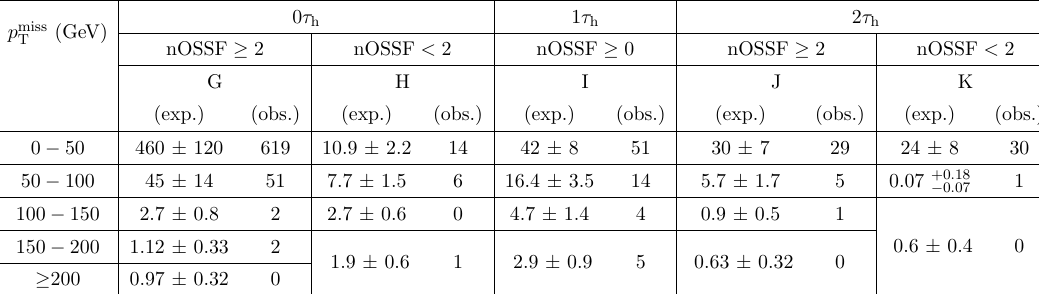
Table 18 . Categories G{K: expected and observed yields in the 4 ‘ category of the analysis. For each bin, the (cid:12)rst number corresponds to the expected yield (exp.) and its uncertainty, and the second denotes the observed yield (obs.). The uncertainty denotes the total uncertainty in the yield.